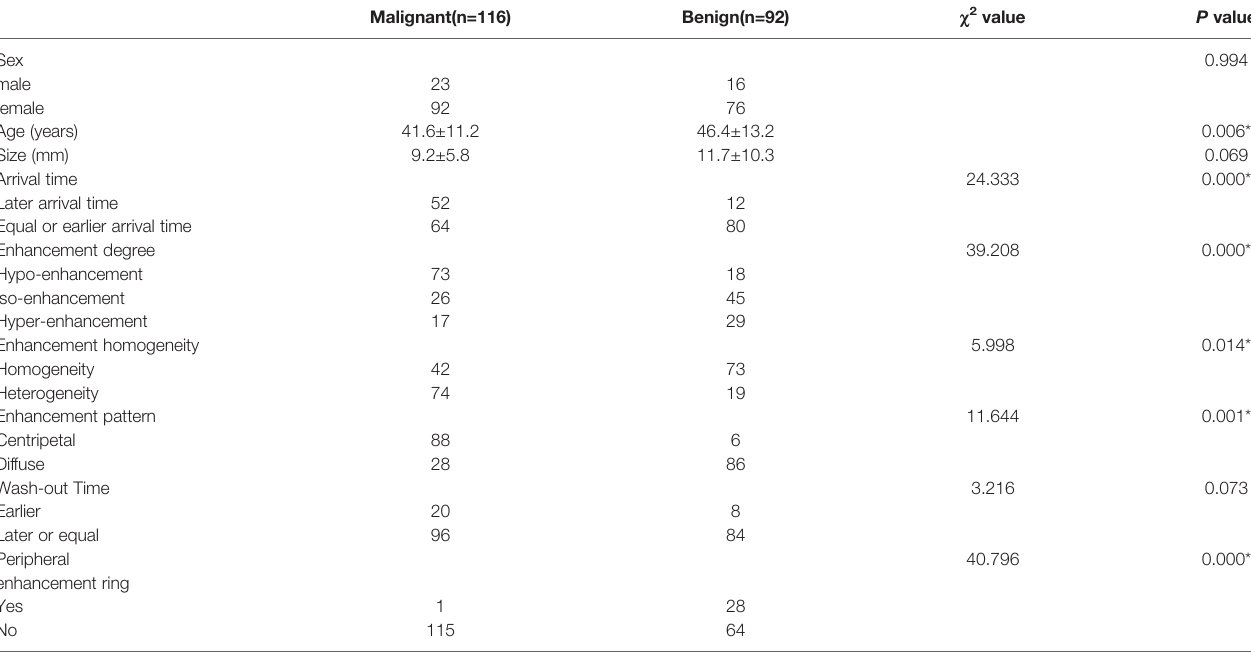
TABLE 2 | CEUS characteristics between malignant and benign thyroid nodules